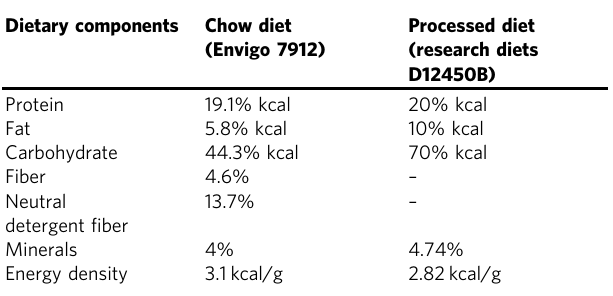
Table 2 Experimental diet composition. Dietary